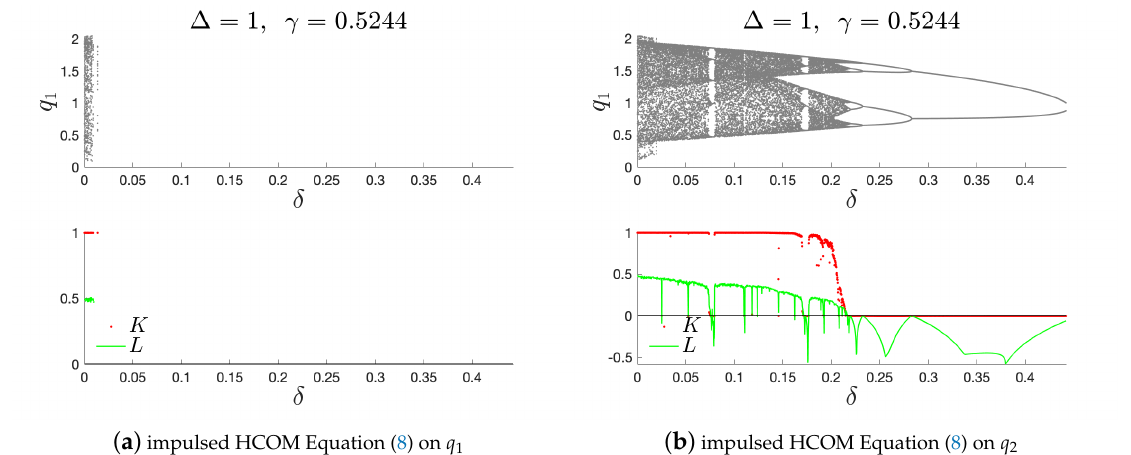
Figure 9. Impulsed HCOM Equation (2) system on q 1 ( a ) and q 2 ( b ): BD δ with ∆ = 1 and γ = 0.5244.